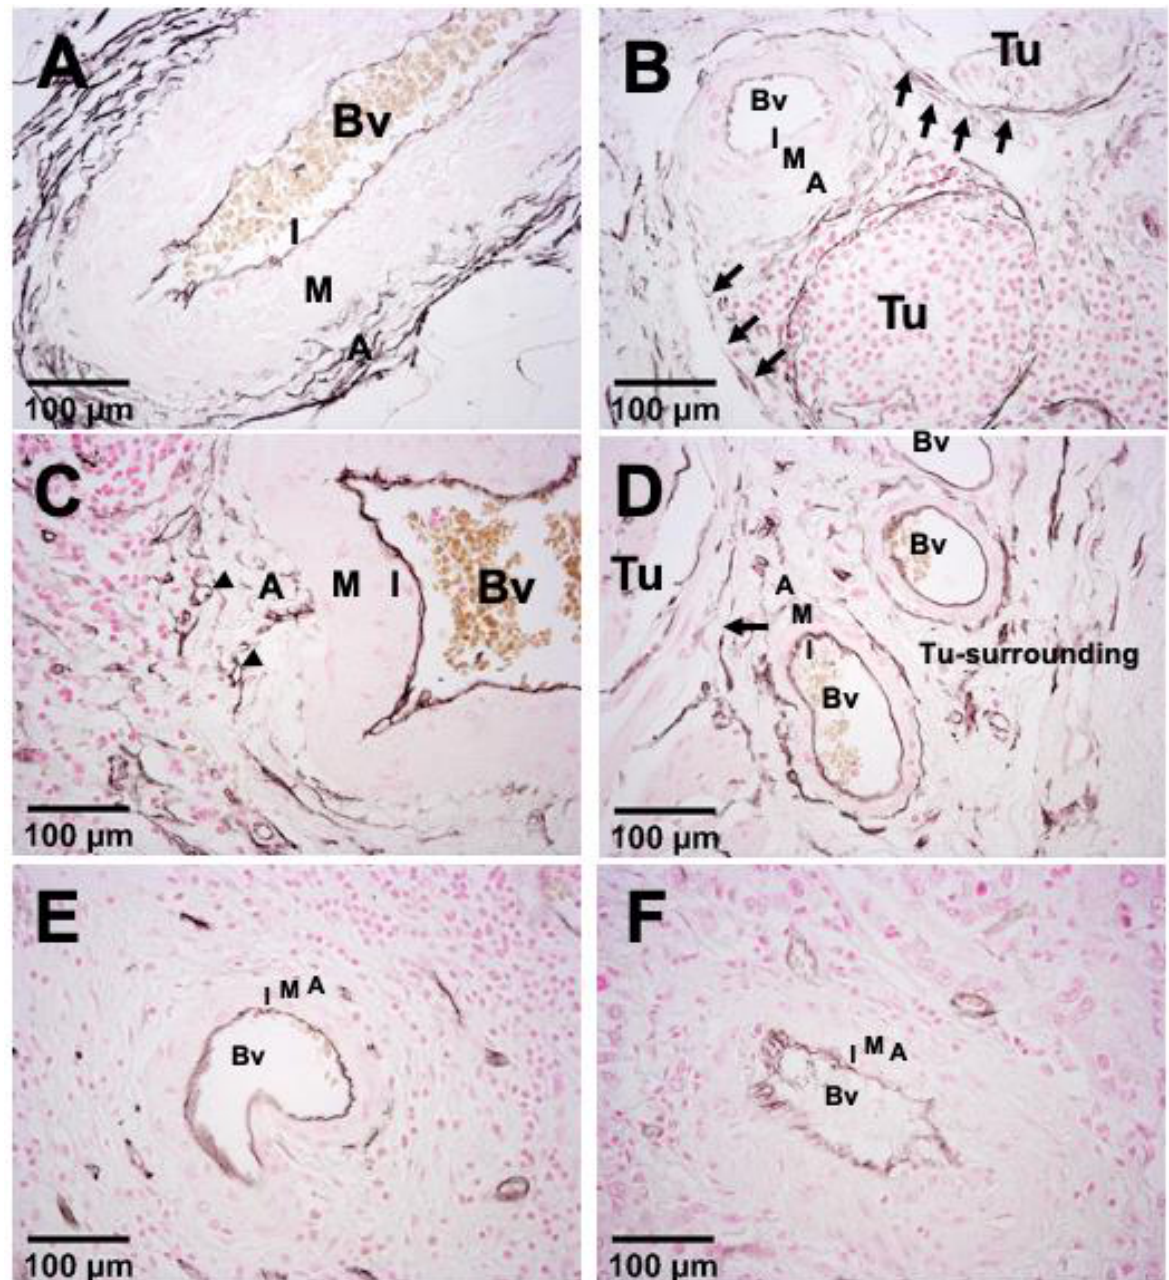
Figure 1. Mobilization of adventitia-resident CD34 + cells in tumors. Stepwise mobilization of adventitial CD34 + cells in human bladder cancer ( A – F ). Artery in the normal, non-transformed tissue surrounding the tumor: a clear, stable CD34 + zone is discernible in the adventitia ( A ). Blood vessel (Bv) in close vicinity to the tumor (Tu): CD34 + cells are partially detached from the adventitia, migrating towards the tumor area (arrows), forming small vessels (arrow heads) ( B , C ). Tumor surrounding area without invasion of tumor cells: CD34 + cells are still detectable in the entire adventitia of the blood vessels ( D ). Blood vessels that are fully enclosed by the tumor: the adventitia is depleted of CD34 + cells ( E , F ). Abbreviations: Bv — blood vessel; Tu — tumor; I — vascular intima; M — vascular media; A — vascular adventitia.